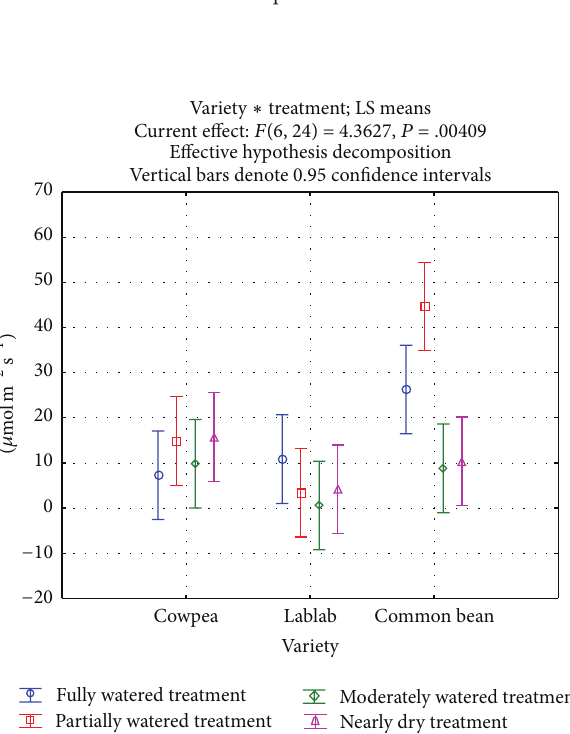
Figure 13: Transpiration on 58 DAP.